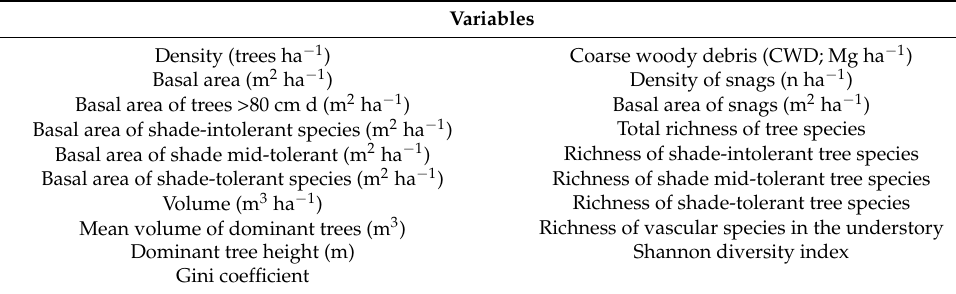
Table 2. Compositional and structural variables selected for comparisons between second- and old-growth forests of south-central